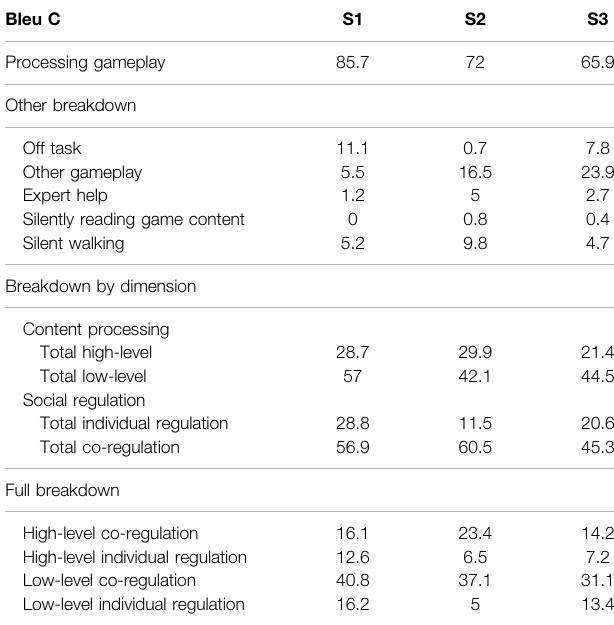
TABLE 3 | Fran 160 team Bleu C ’ s percentage of time per category for each